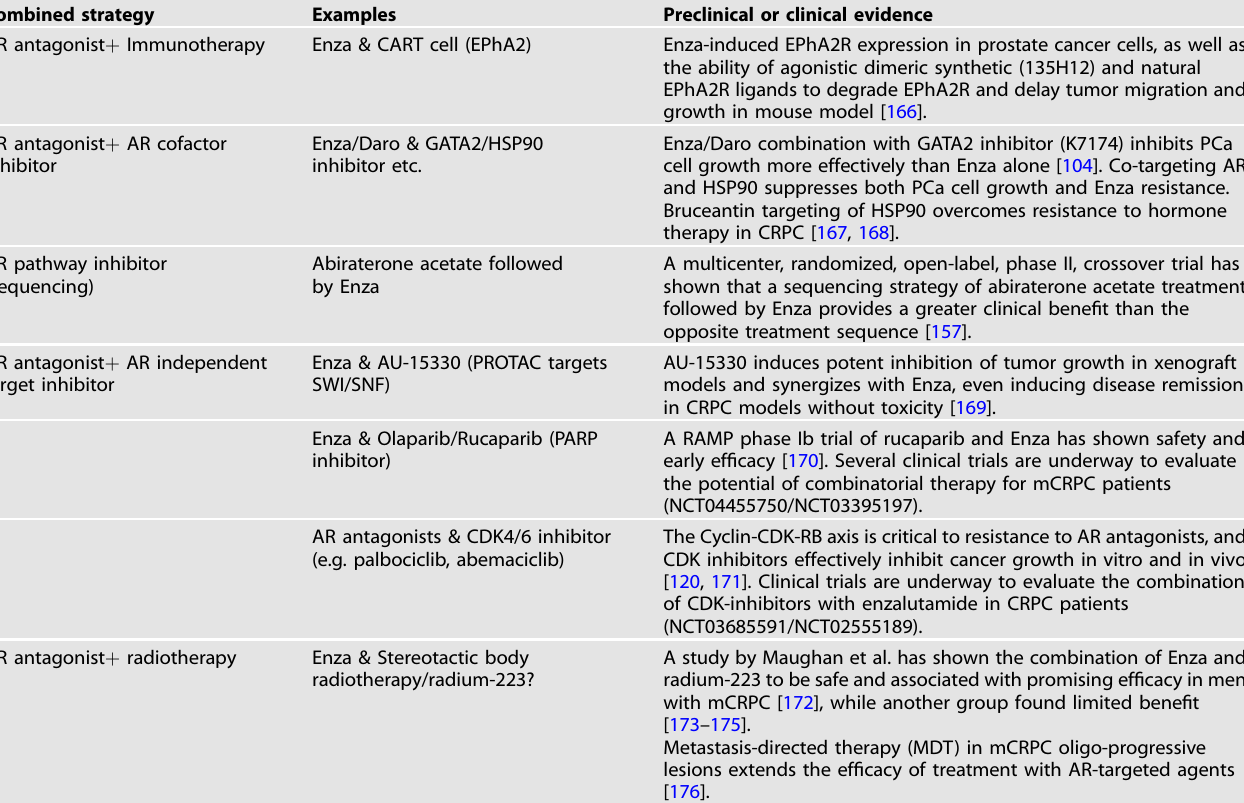
Table 3. Potential therapeutic combinations of AR antagonists with other